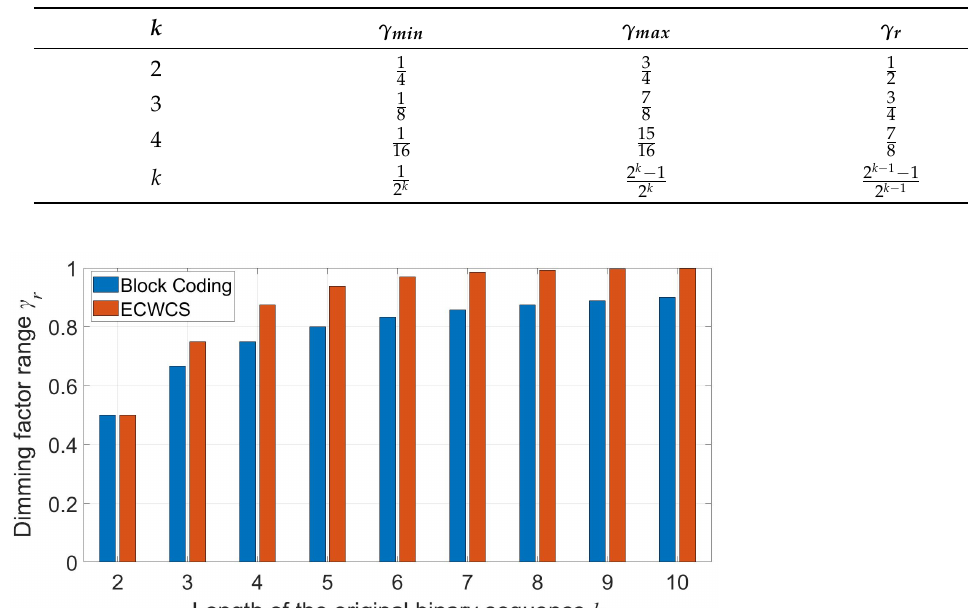
Table 4. The dimming range of the proposed ECWCS scheme under different k .